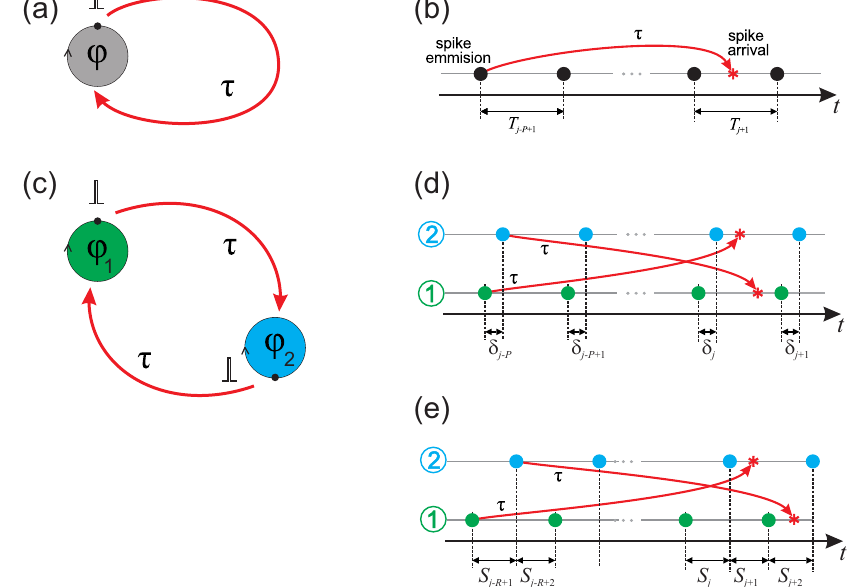
Fig. 1 Dynamics of the oscillators with pulse delayed coupling and derivation of the discrete maps. Dots depict the moments of spikes emission. (a) Single oscillator with delayed feedback and (b) its dynamics. Each spike produced arrives to the oscillator after delay time τ . T j are the inter-spike intervals. (c) Two oscillators with mutual delayed